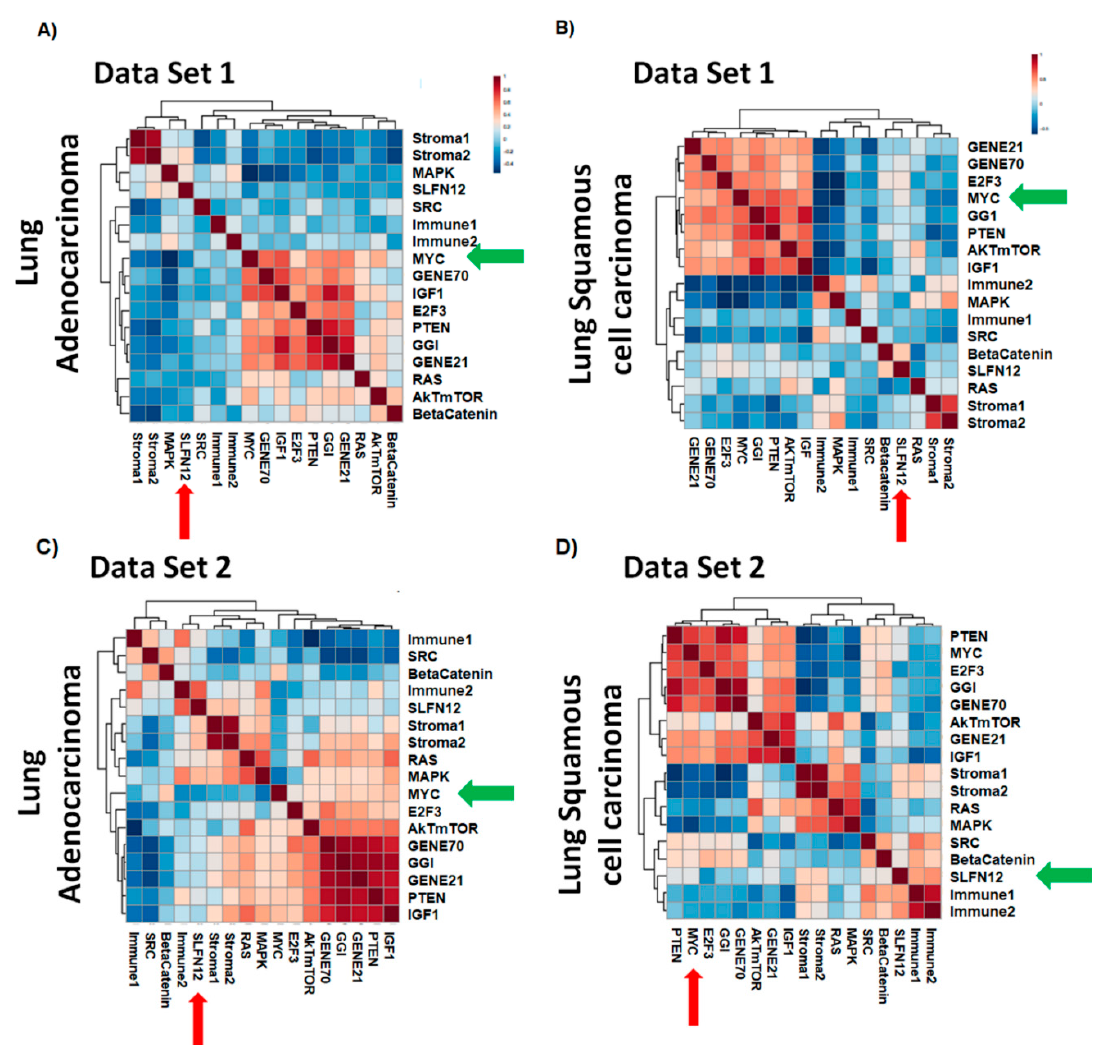
Figure 4. SLFN12 correlates with gene signatures in human lung carcinoma. Heatmap of correlation levels between 17 previously defined cancer-related gene signatures using two datasets of lung cancer patients. Heat maps derived from dataset 1 are shown in ( A ) for lung adenocarcinoma ( n = 77) and in ( B ) for lung squamous cell carcinoma ( n = 73). Heat maps derived from dataset 2 are shown for ( C ) lung adenocarcinoma ( n = 40) and ( D ) lung squamous cell carcinoma ( n = 18).